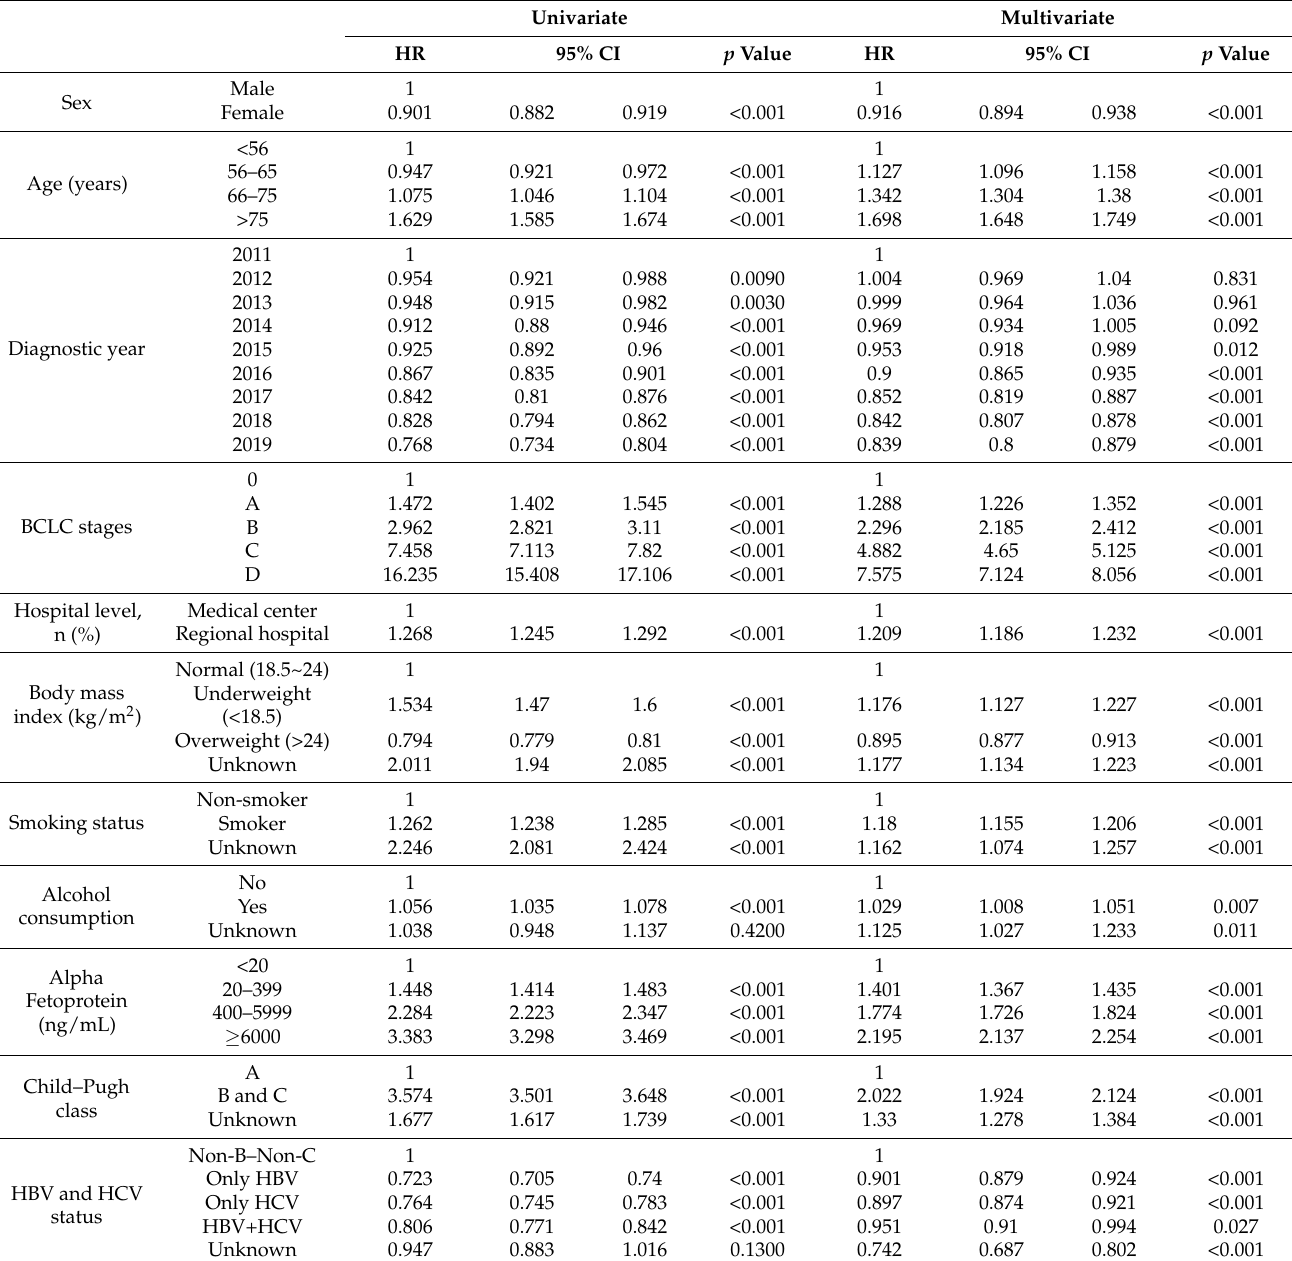
Table 1. Factors associated with survival of hepatocellular carcinoma from 2011 to 2019 in Taiwan. Univariate Multivariate 95%